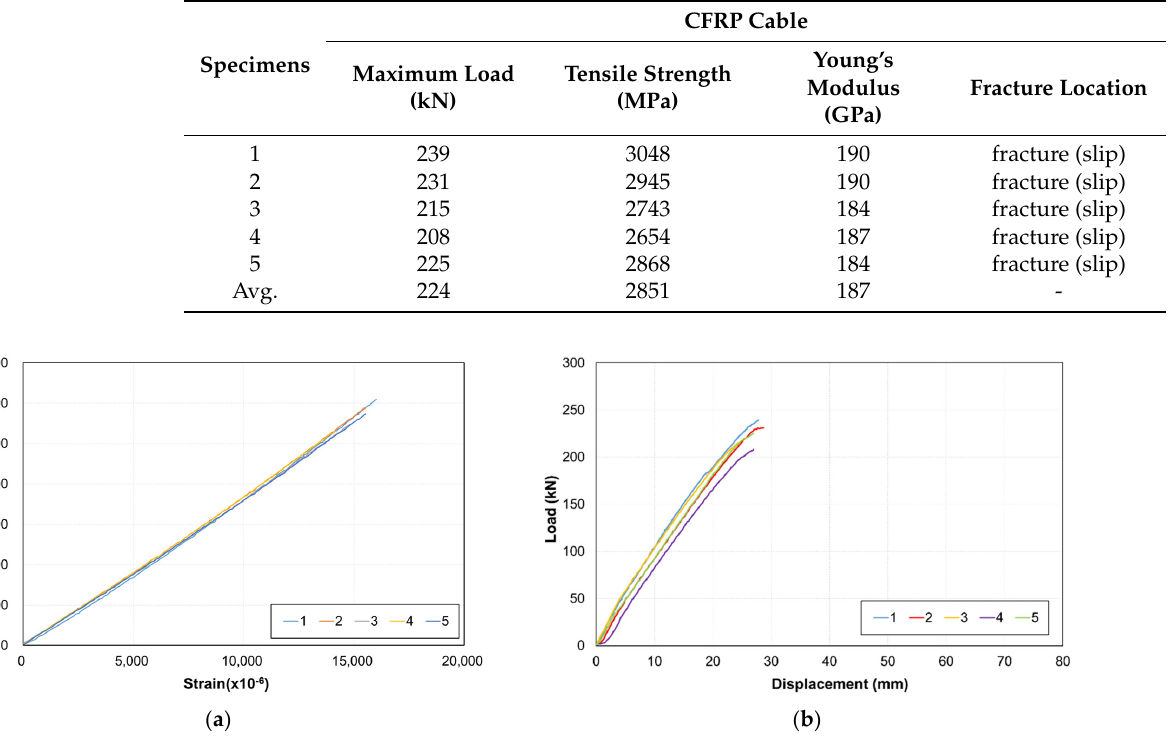
Figure 5. Sample specimen tensile test results: ( a ) stress and strain and ( b ) load–displacement curves.